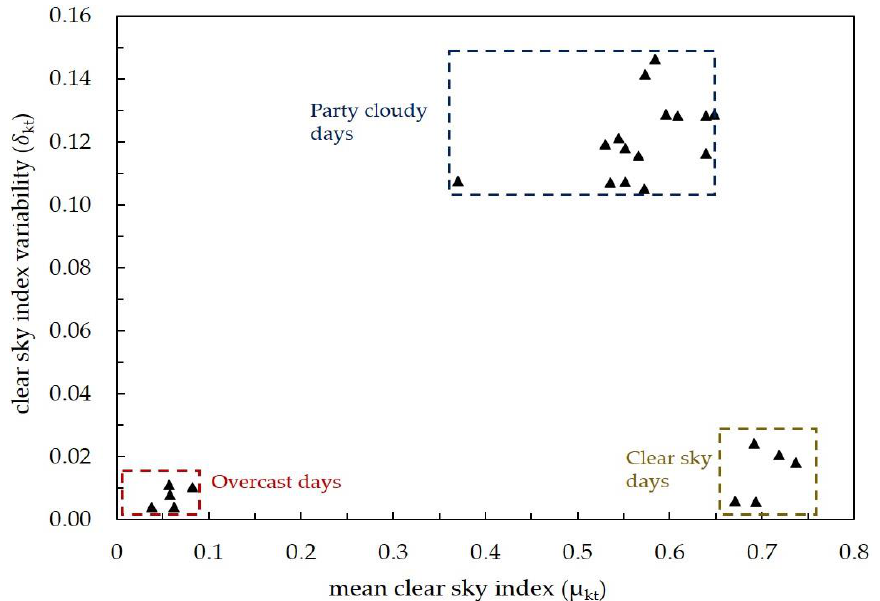
 and clear-sky  and clear-sky kt kt